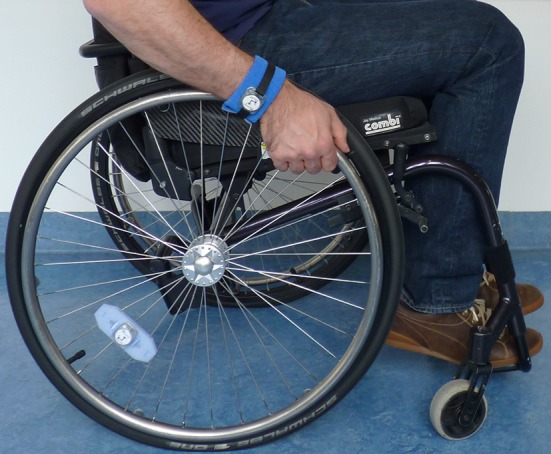
Photograph of one examiner wearing the sensors. One sensor was attached to the right wheel of each wheelchair, one sensor was attached to each wrist.